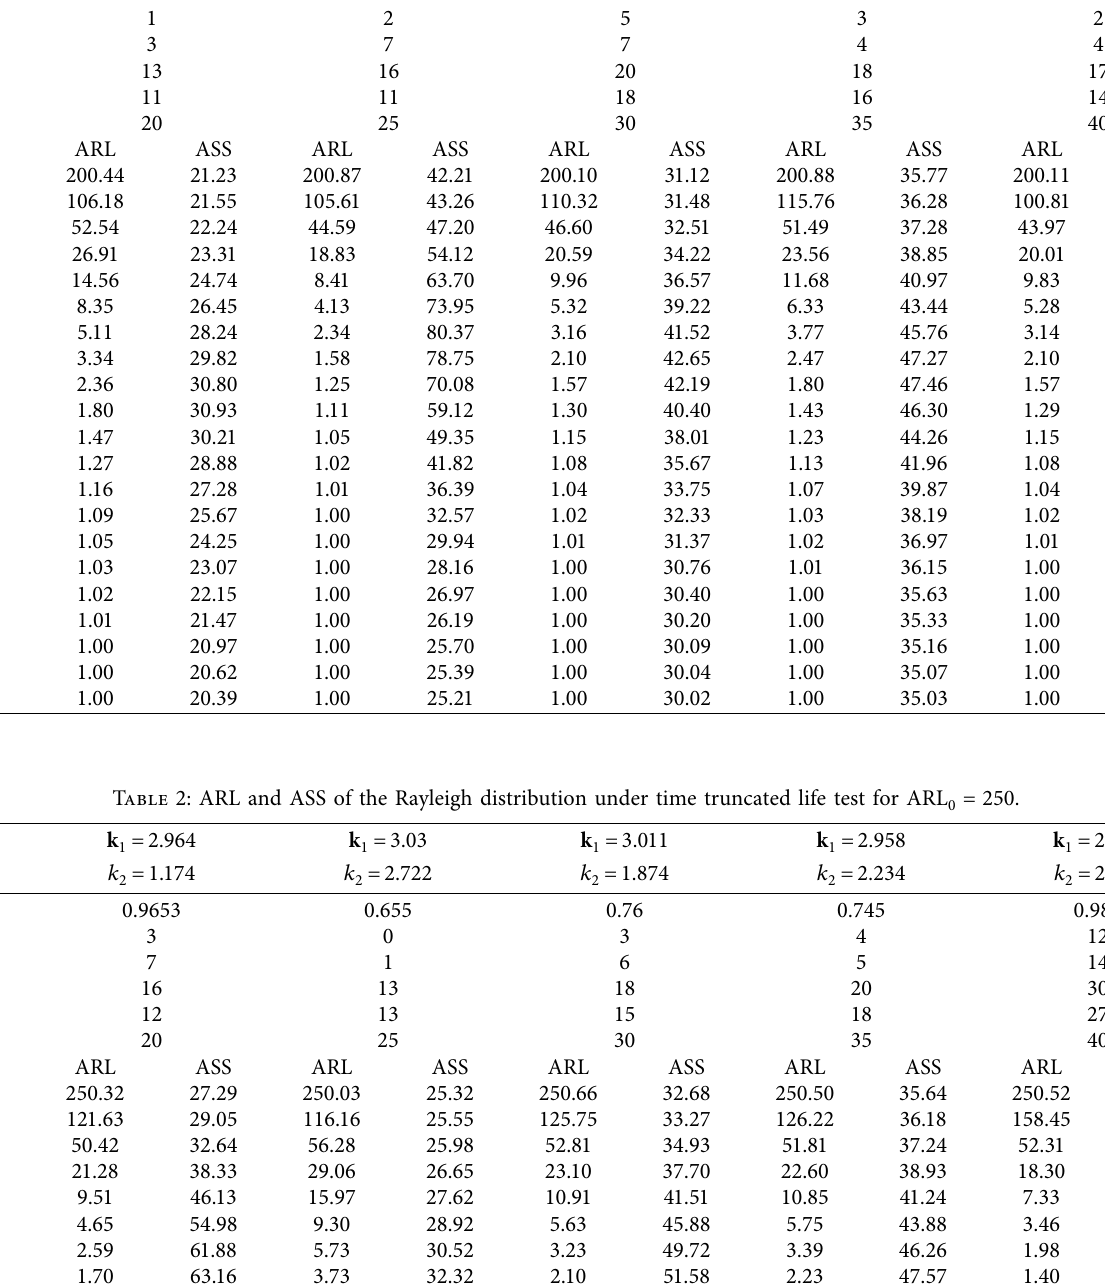
Table 1: ARL and ASS of the Rayleigh distribution under time truncated life test for ARL